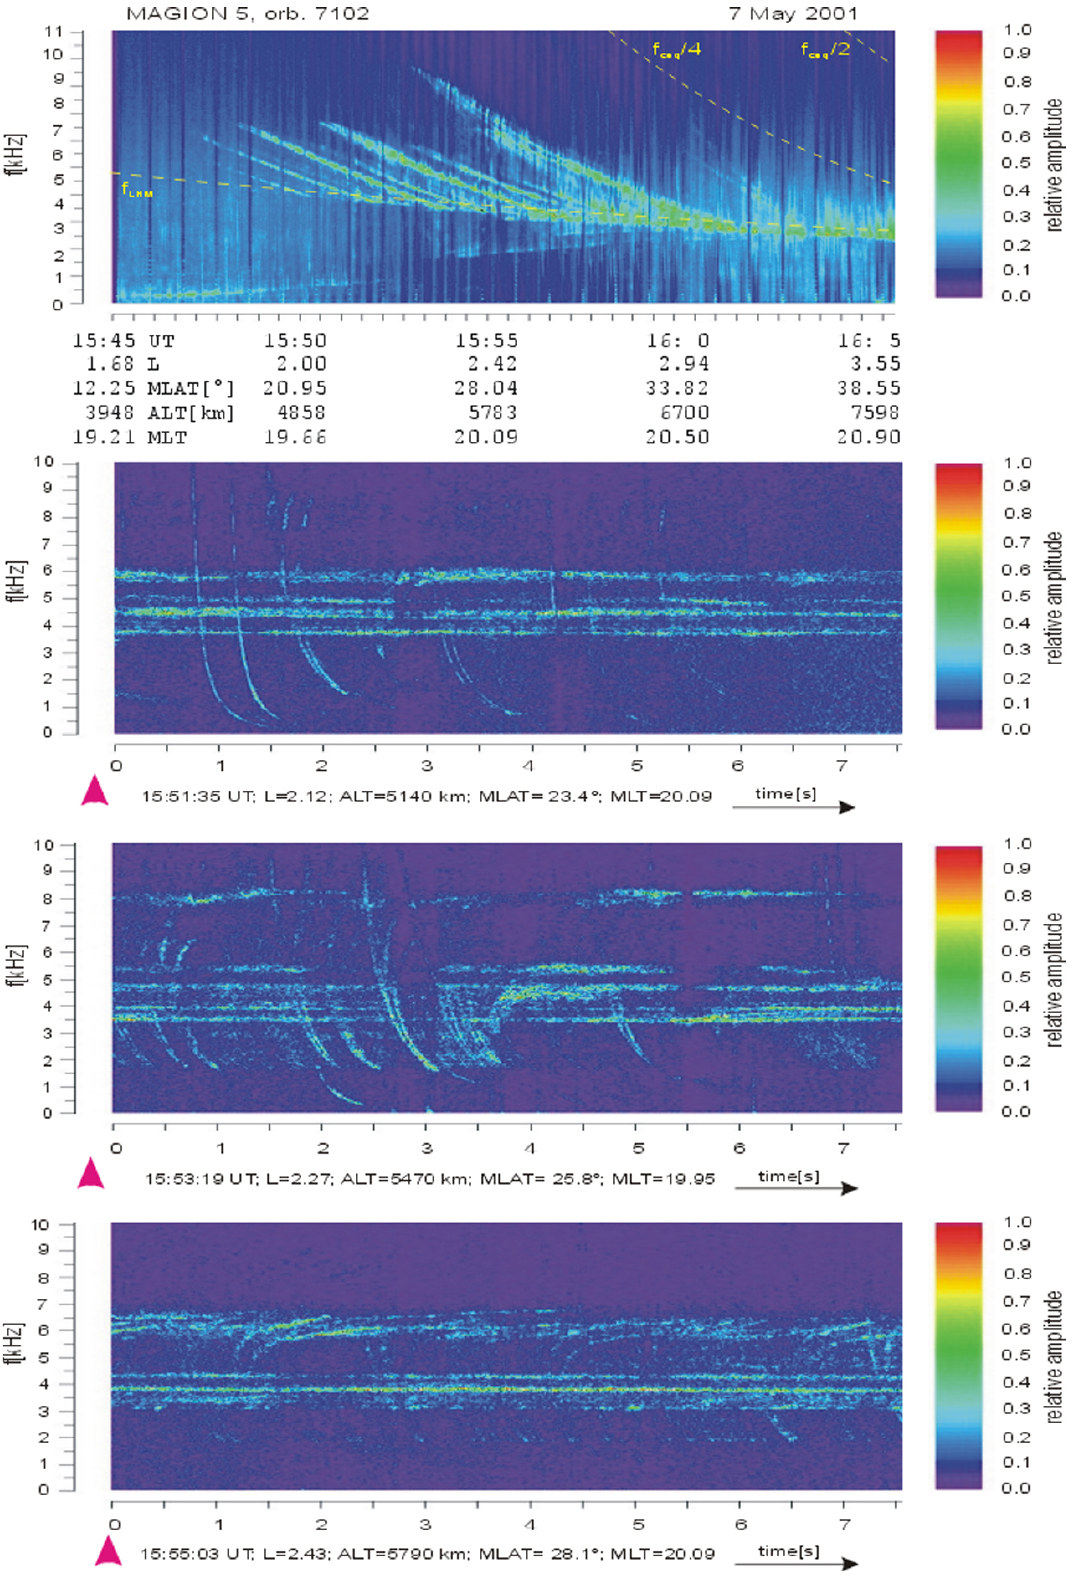
Fig. 11. Overview and detailed spectrograms along MAGION 5 orbit